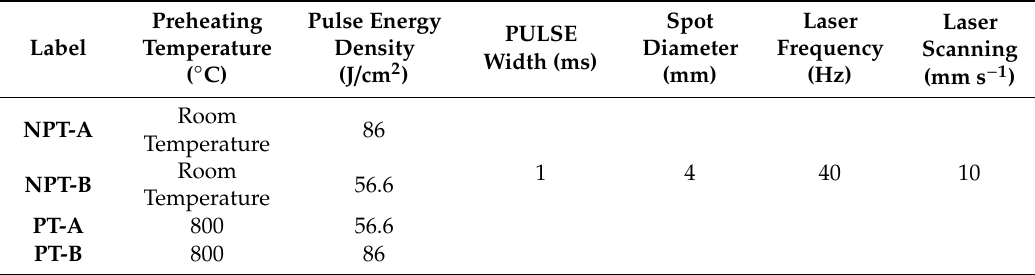
Figure 2. ( a ) Schematic diagram and ( b ) experimental setup of the LSR system. Table 1. Experimental parameters of LSR.